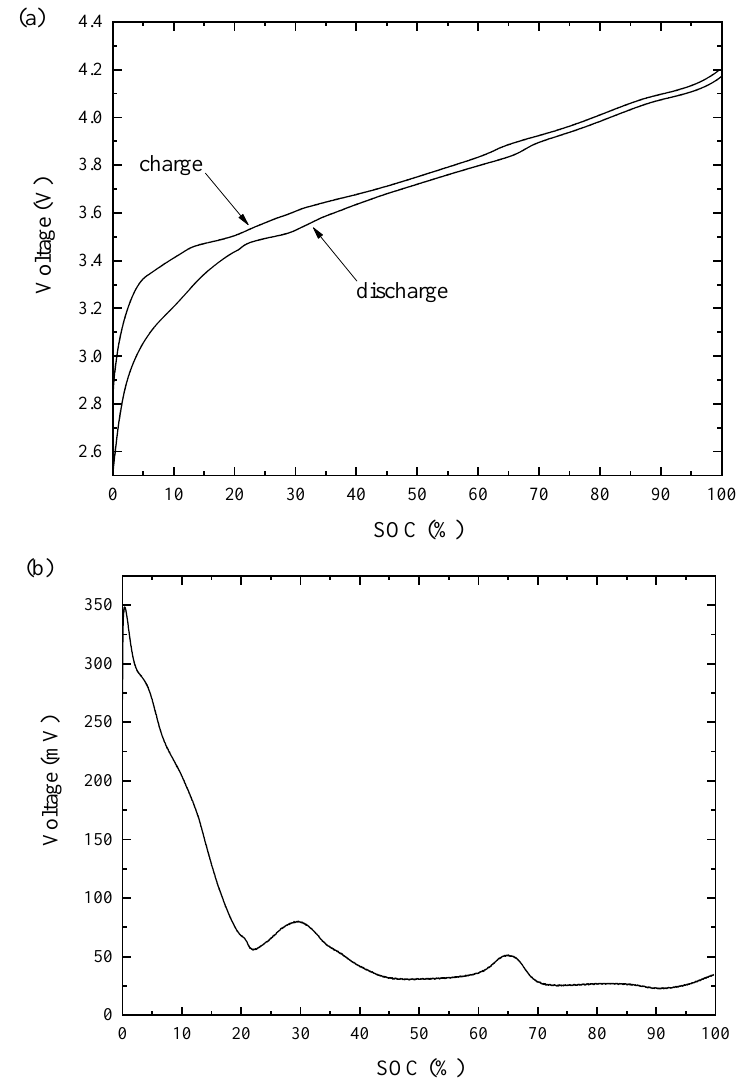
Figure 1. The schematic diagram of the one-state hysteresis equivalent circuit model (ECM). The hysteresis effect between the charge and discharge boundary curves is illustrated in Figure 2a. The curves are obtained by charging/discharging the cell at C/25 rate (a current corresponding to the manufacturer’s rated capacity for a 25 h discharge to low cut-off voltage) at a temperature of 30 °C;